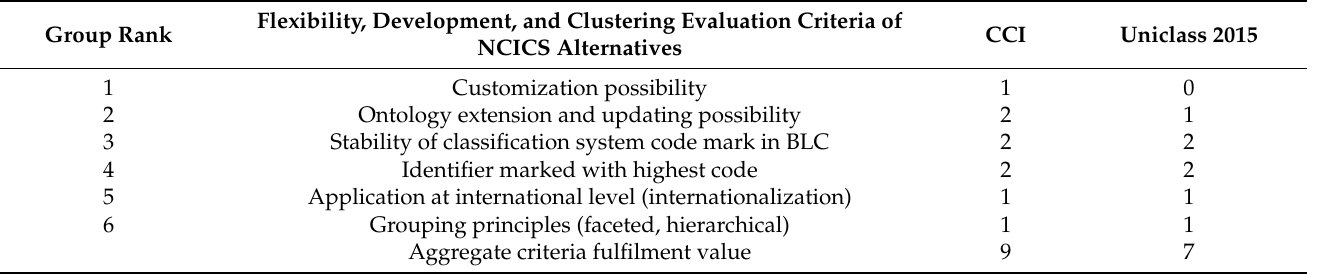
Table 8. Flexibility, development, and clustering evaluation criteria of NCICS alternatives, their ranking in order of importance, and compliance with alternatives.